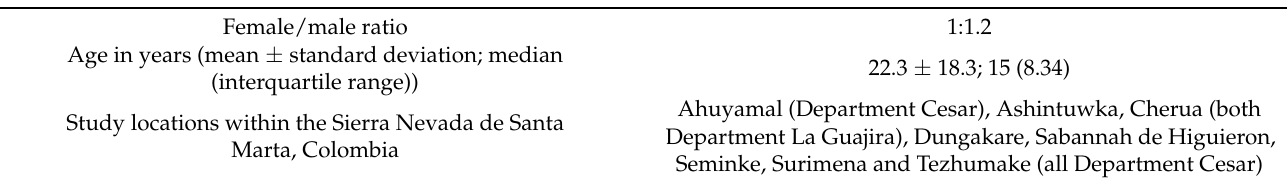
Table 1. Summary of the assessed Indigenous study population, comprising 518 individuals from a region with a high prevalence of Typanosoma spp. DNA in peripheral